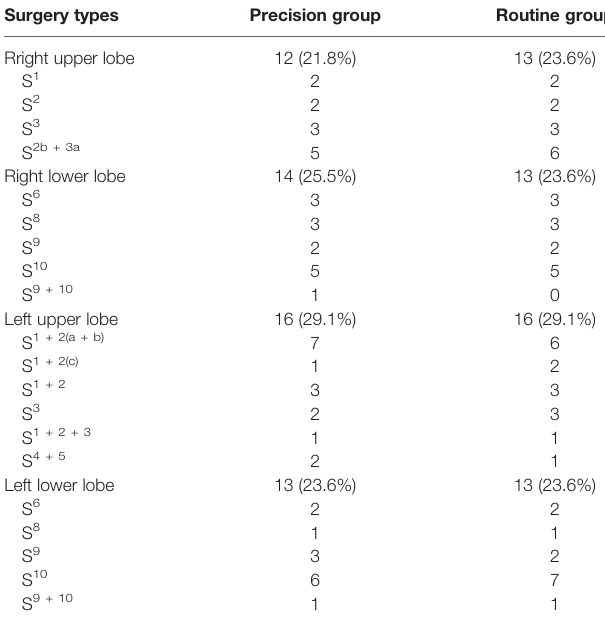
TABLE 2 | Types of VATS segmentectomy in Precision group and Routine